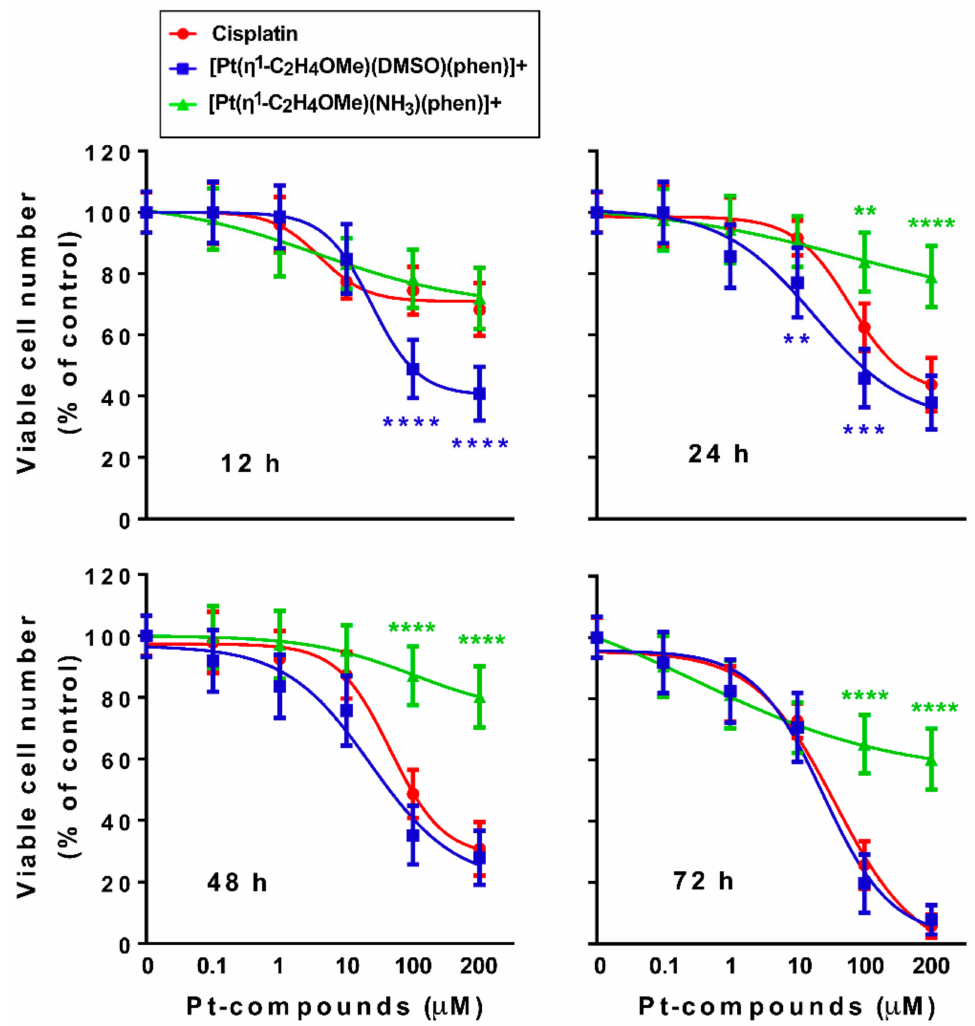
Figure 5. Cell viability assay after [Pt( η 1 -C 2 H 4 OMe)(DMSO)(phen)] + , [Pt( η 1 - C 2 H 4 OMe)(NH 3 )(phen)] + , and cisplatin treatments in SK-OV-3 cell line. The viability of the ovarian adenocarcinoma cell line was evaluated after treatment with Pt compounds at different concentrations (0.1, 1, 10, 100 and 200 µ M) for 12, 24, 48, and 72 h. The data are means ± S.D. of three different experiments run in eight replicates and are presented as percent of control. Asterisks indicate values that are significantly different (** p < 0.01; *** p < 0.001; **** p < 0.0001) from those of cisplatin at the same concentrations and time